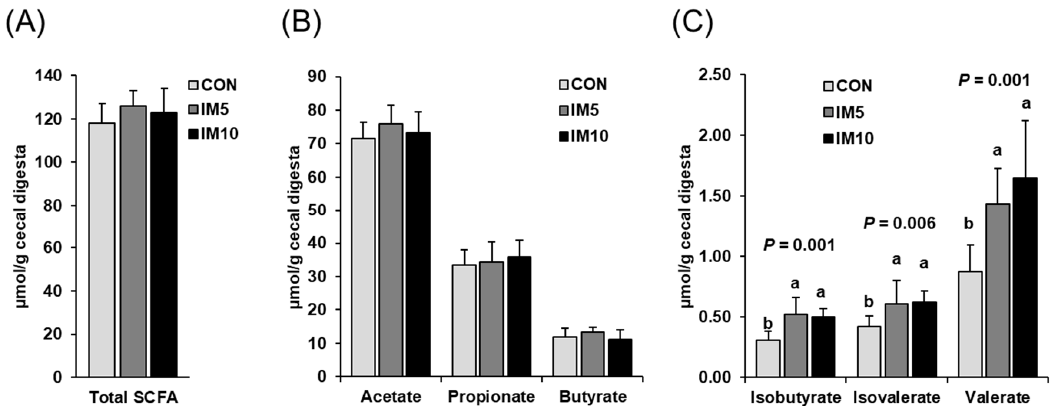
Figure 4. Concentrations of short-chain fatty acids (SCFA) in the cecal digesta of pigs fed isonitrogenous diets without (CON) or with 5% (IM5) or 10% Tenebrio molitor larvae meal (IM10) for four weeks. ( A ) total SCFA reflecting the sum of all SCFA detected; ( B ) individual main SCFA (acetate, propionate, butyrate); ( C ) individual minor SCFA (isobutyrate, isovalerate, valerate). Bars are means ± SD for n = 10 pigs per group. a,b Values with different superscripts differ significantly at p <